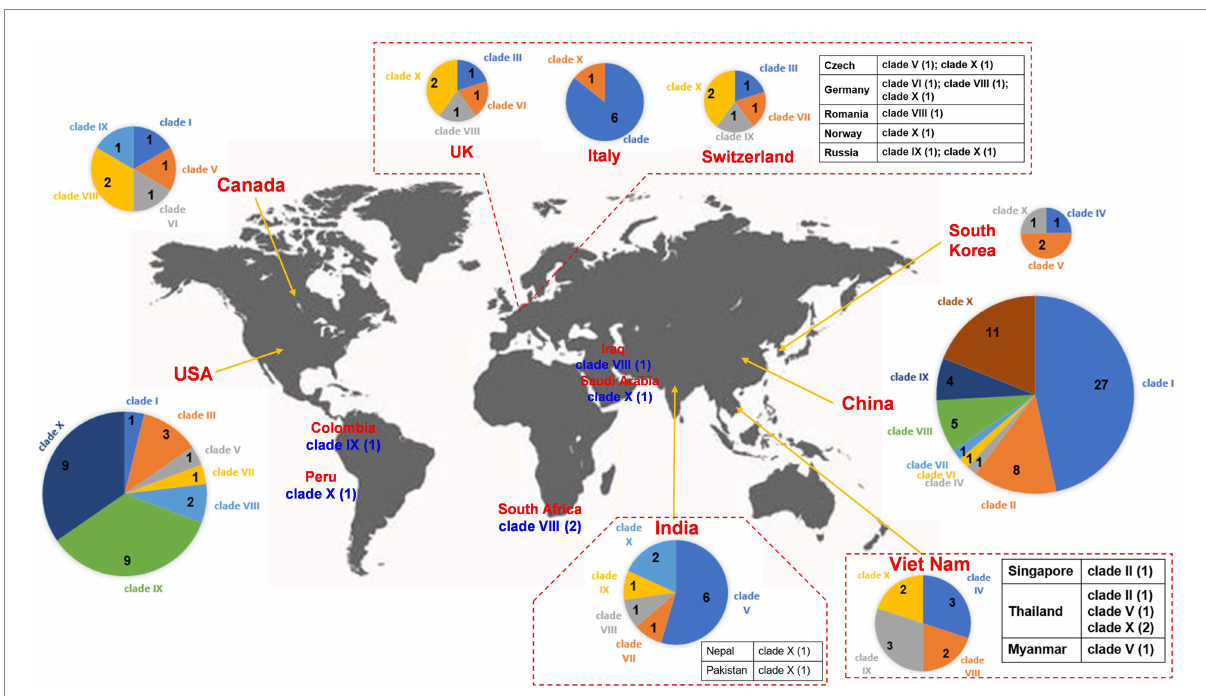
FIGURE 3 Worldwide distribution of bla NDM -harboring plasmids of K. pneumoniae . The geographical distribution of the 10 clades (Clade I–Clade X) from the bla NDM -positive plasmids of K. pneumoniae was calculated and displayed by pie chart. For the plasmids isolated in European countries, only those from the United Kingdom, Italy, and Switzerland were displayed by pie chart, others were displayed in the tabular form. For the plasmids isolated in Southeast Asia, only those from Viet Nam were displayed by pie chart, others were displayed in the tabular form. For the plasmids isolated in South Asia, only those from India were displayed by pie chart, others were displayed in the tabular